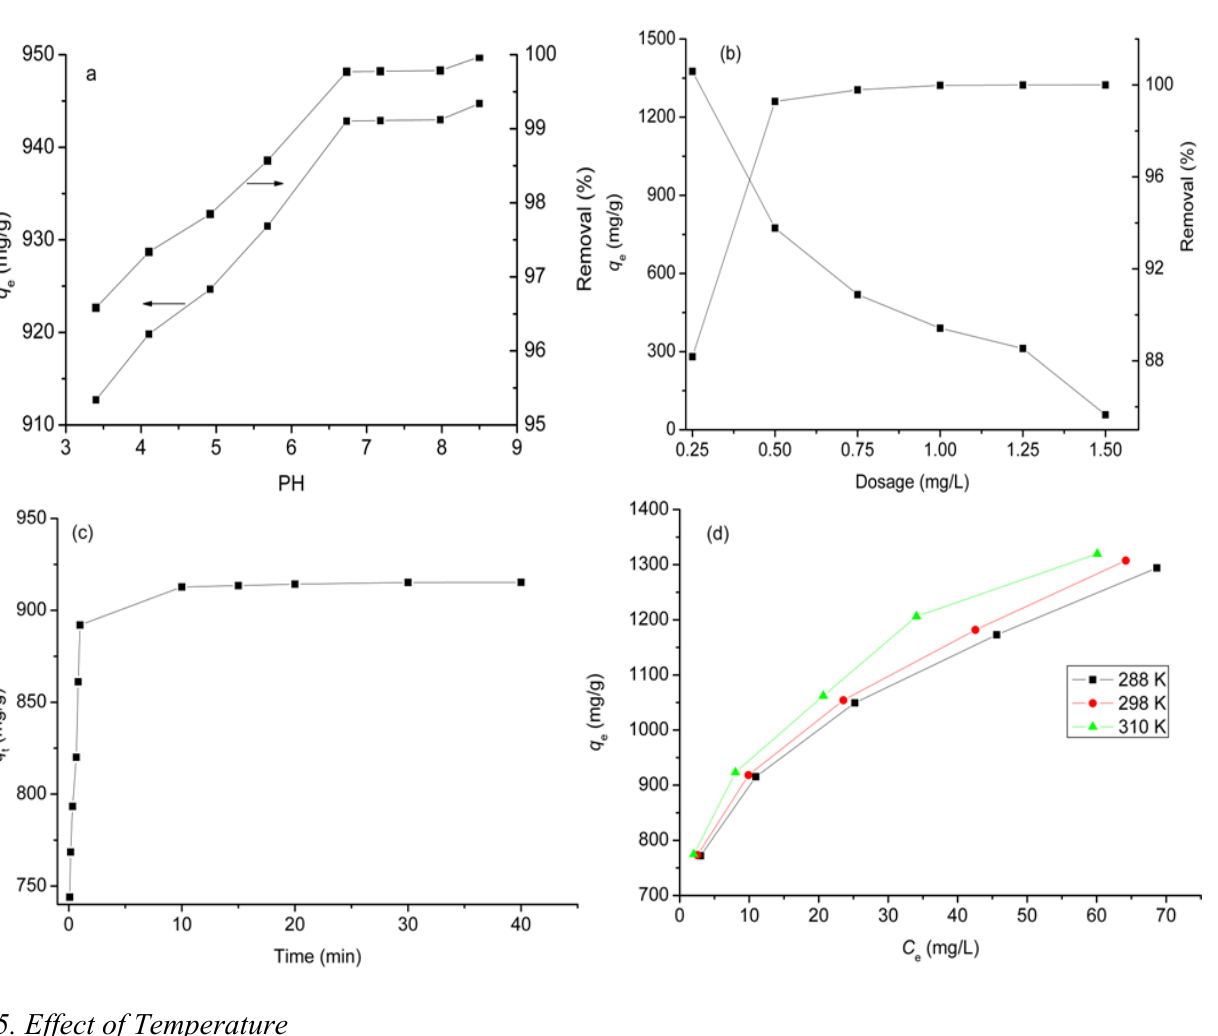
Figure 4. Influences of experimental parameters on the adsorption of DOX on GO: ( a ) pH effect (dosage = 0.5 g/L, temperature = 288 K, concentration = 350 mg/L); ( b ) dosage effect (temperature = 288 K, concentration = 500 mg/L, pH = 3.4); ( c ) contact time on effect (concentration: 350 mg/L; dosage: 0.5 mg/L; temperature: 288 K; pH: 3.4); ( d ) temperature effect (dosage: 0.5 mg/L; temperature: 288 K; pH: